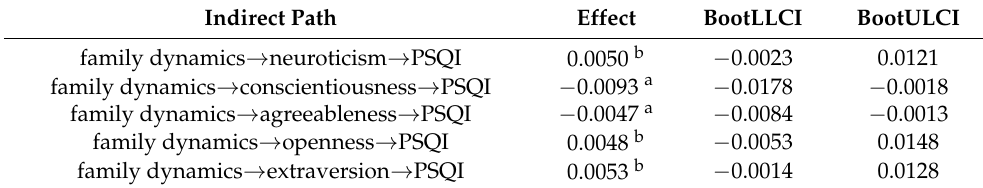
Table 4. Bootstrapping indirect effect and 95% confidence interval (CI) for the mediation